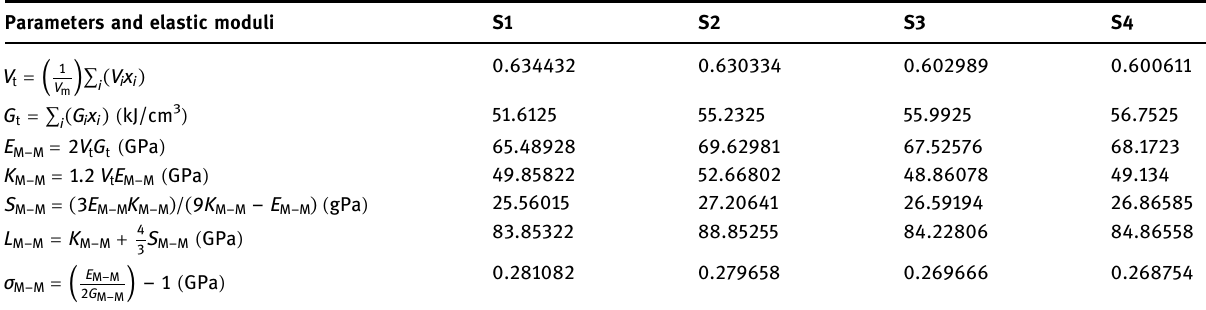
Table 3: Total ionic packing density ( V t ) , total dissociation energy ( G t ) , Young ’ s modulus ( E M – M ) , bulk modulus ( K M – M ) , shear modulus ( S ) , and Poisson ’ s ratio ( σ ) based on the Makishima – Mackenzie model of the studied glasses. M – M M – M Parameters and elastic